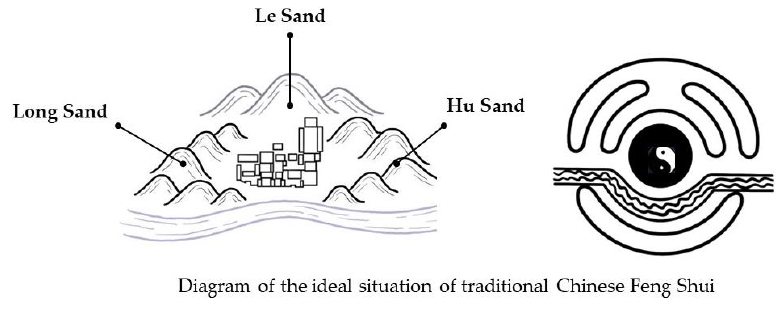
Figure 1. Ancient Chinese architectural design concepts.